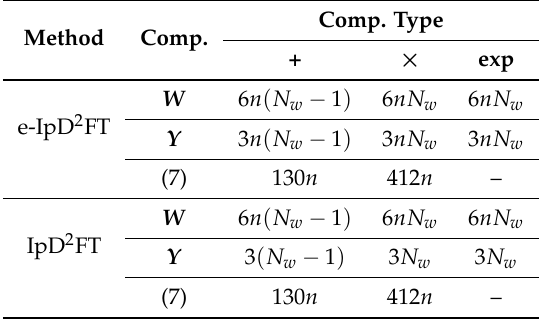
Table 2. Computational complexity of the e-IpD 2 FT and IpD 2 FT. The computation types + and × denote complex addition and multiplication,